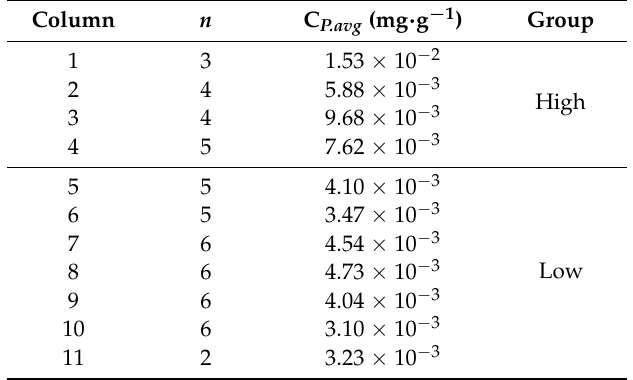
Table 4. Lateral variation in average surface Fr.W P concentrations. Data are presented starting from the right side of the delta (looking upstream). Column 1 contains points 7–9 seen in Figure